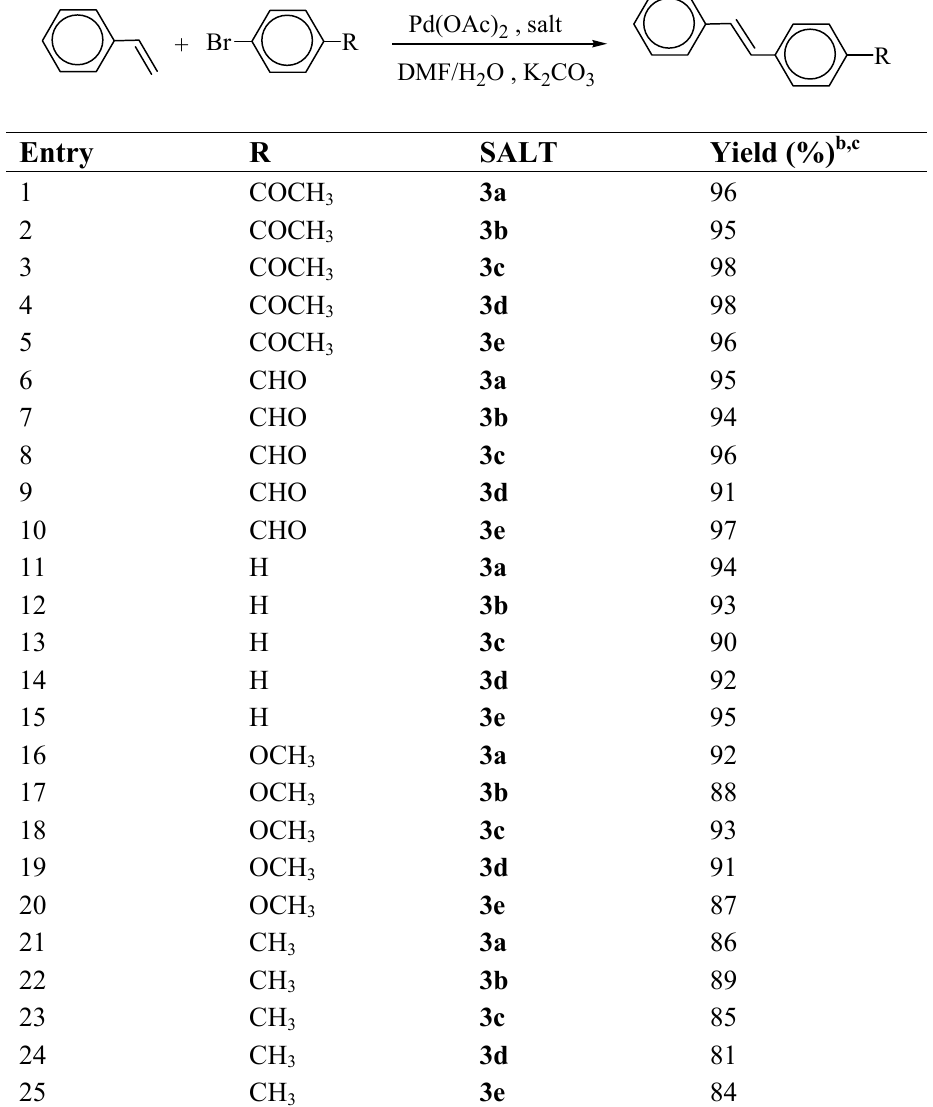
Table 1. The Heck coupling reaction of aryl bromides with